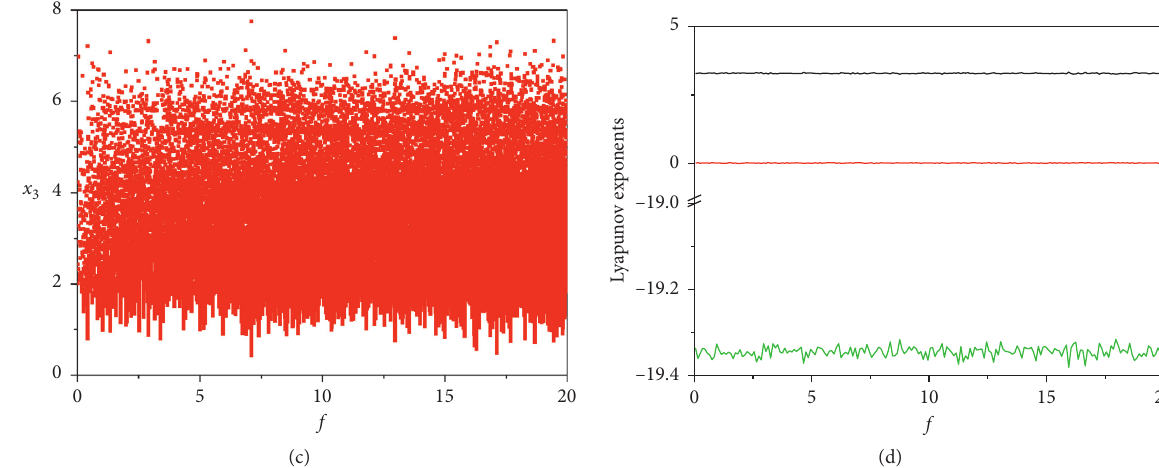
Figure 2: (a, b, c) Bifurcation diagram versus f ; (d) finite time Lyapunov exponent spectrum versus f .